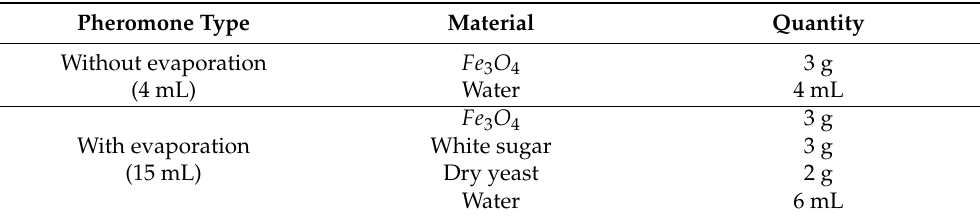
Table 2. Details of ingredients and proportions to implement ferrofluid pheromone. Final volume of solution indicated in